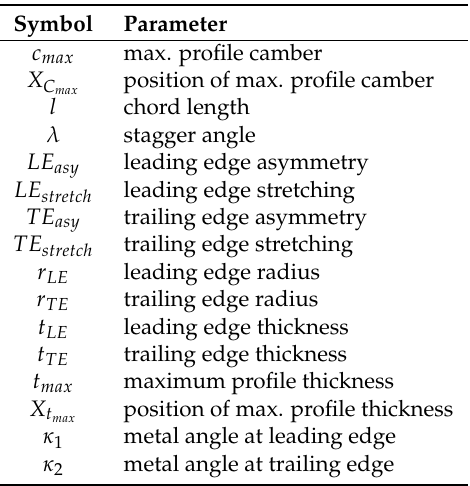
Table 1. Geometric